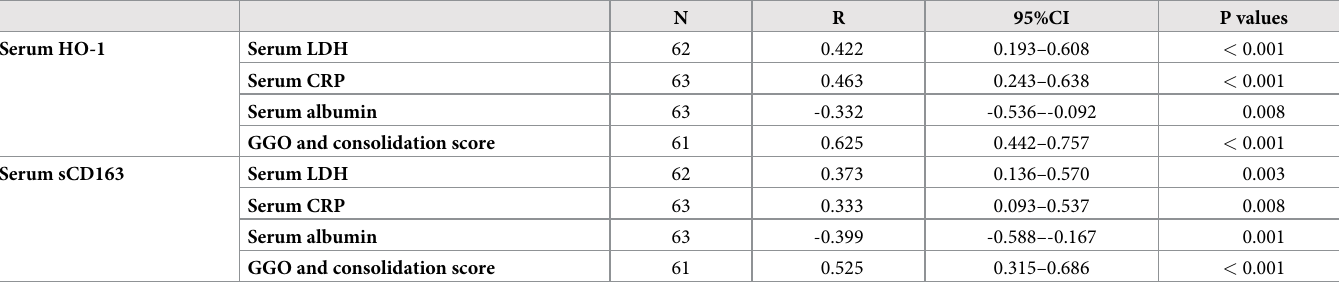
Table 2. The relationships between serum HO-1 or sCD163 and other clinical parameters.